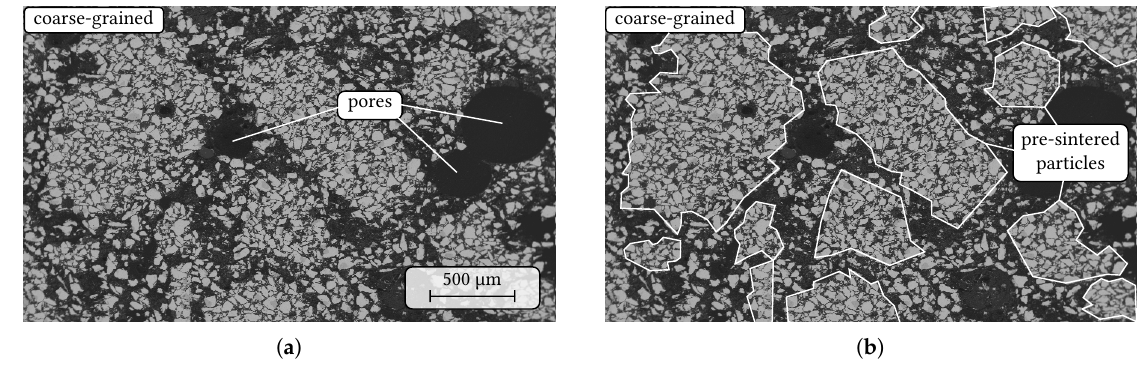
Figure 9. SEM micrograph (BSE contrast) of the coarse-grained composite with niobium (light grey) and alumina (dark grey). ( a ) overview with pores up to a few hundreds micrometers size, ( b ) the same micrograph with indicated particle boundaries of the pre-sintered aggregates.